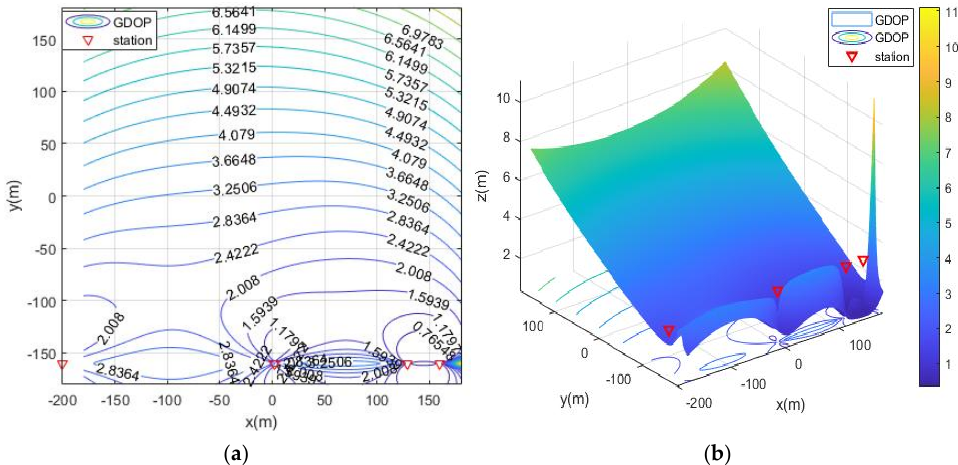
Figure 10. GDOP contour map of optimization results with 4 base stations located on single-side of the positioning area ( a ) 2D contour map of moa04; ( b ) 3D contour map of moa04.